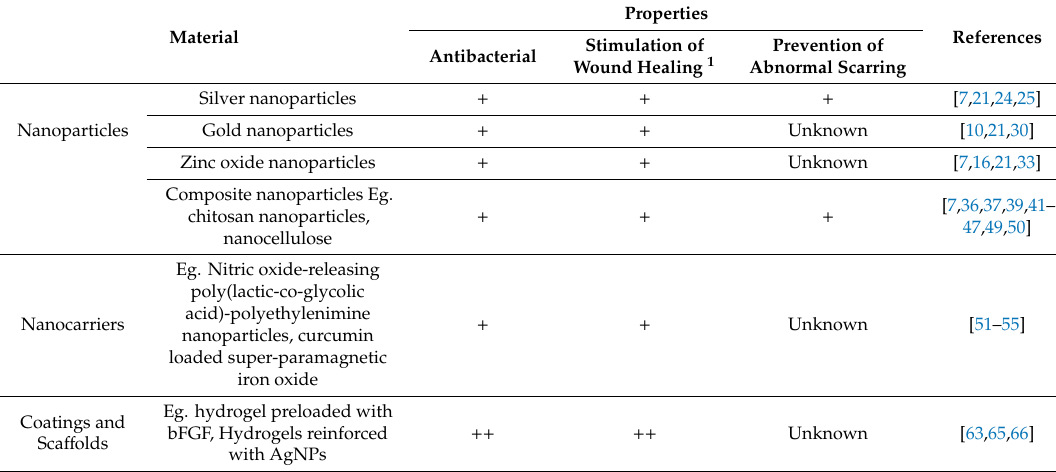
Table 1. Properties of nanomaterials developed for wound management. bFGF—basic fibroblast growth